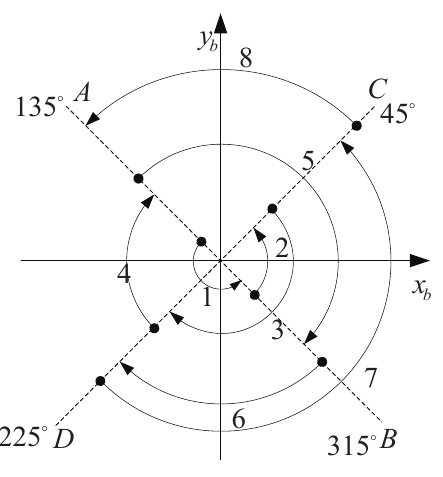
Figure 8. IMU rotating